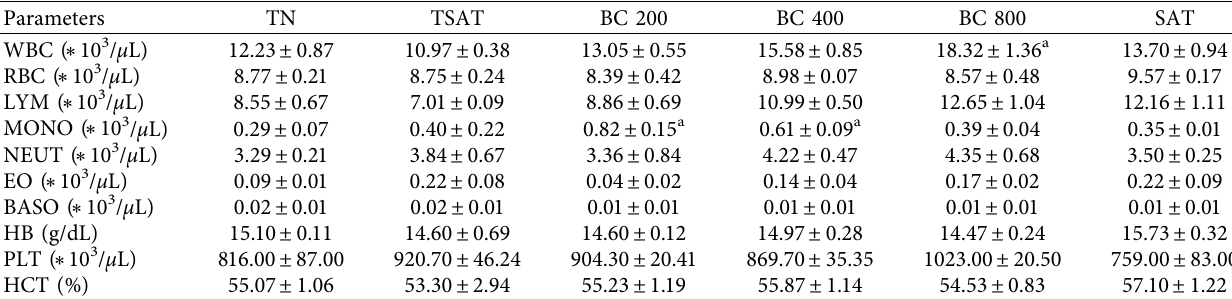
Table 7: Efects of the plant mixture aqueous extract on the blood elements in